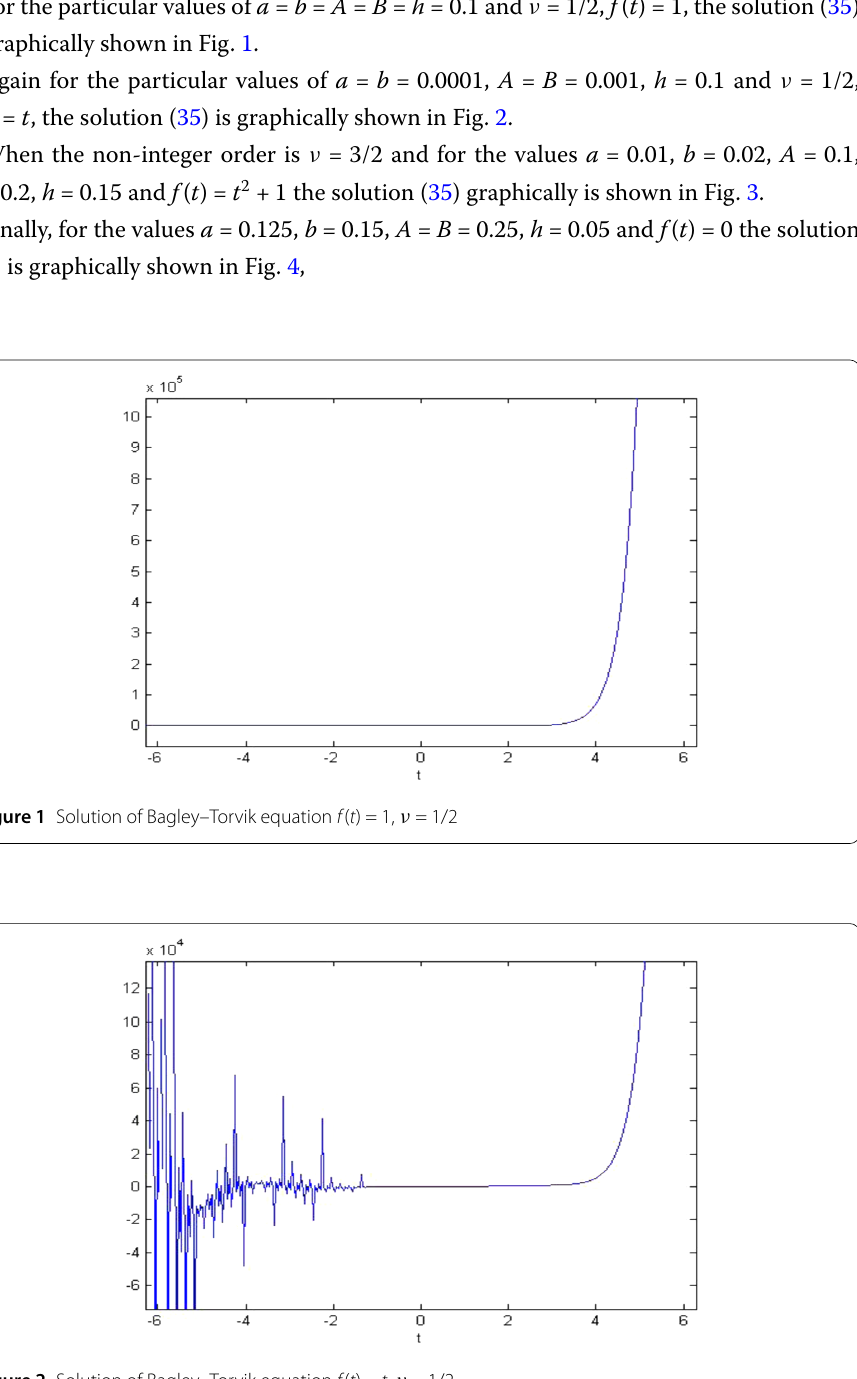
Figure 2 Solution of Bagley–Torvik equation f ( t ) = t , ν =